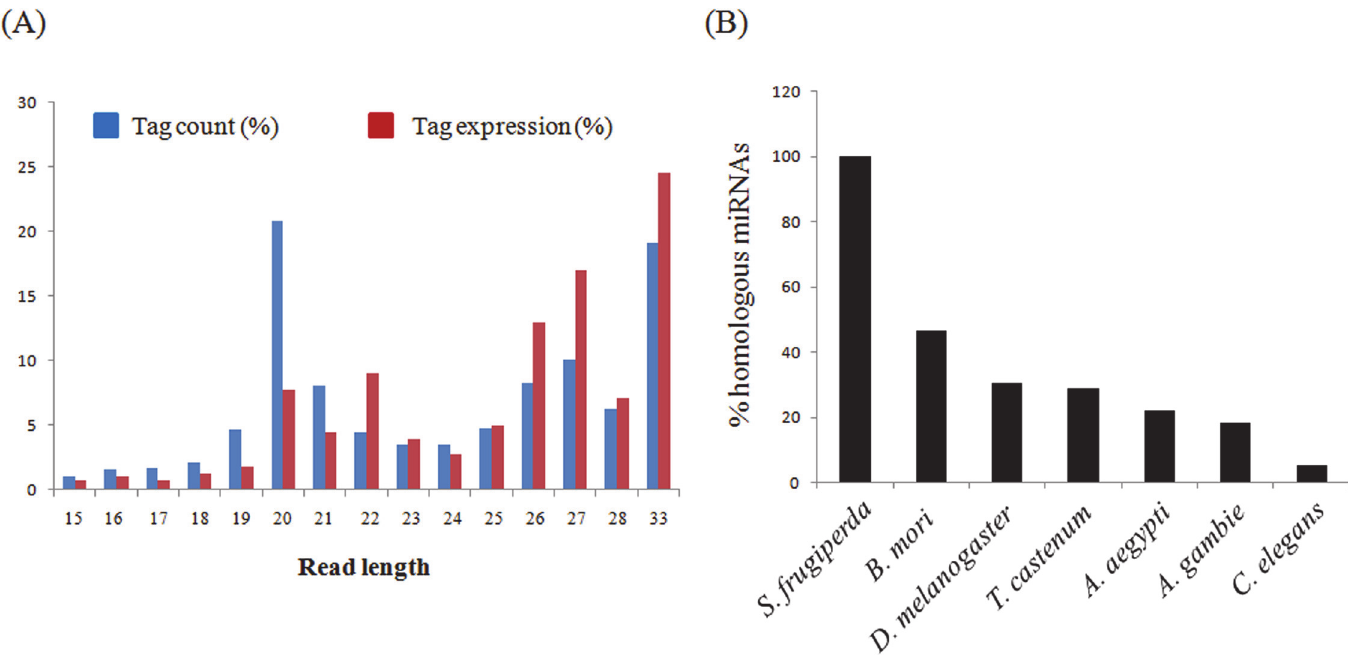
Fig 1. Analysis of small RNA reads and conservation of homologous miRNAs. (A) The sequence length distribution of small RNA read tags in Sf21 cells showed majority of the population at 20 nt, a typical length of mature miRNAs followed by the read lengths around 27 nt which could be putative piRNA sequences. (B) Percentage of known miRNAs from Spodoptera frugiperda with homologs from other insects; B. mori, D. melanogaster, T. castenum, A. aegypti, A. gambie and C. elegans .